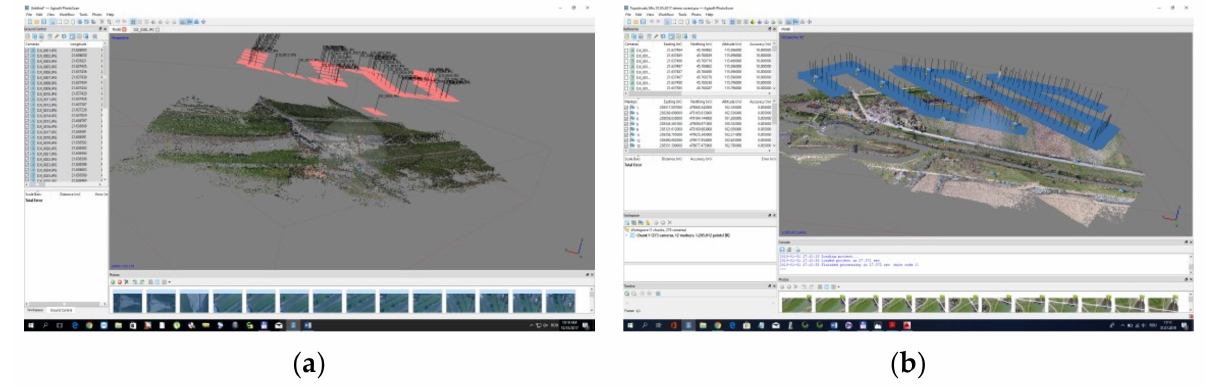
Figure 12. Alignment of images: ( a ) session I-a; ( b ) session